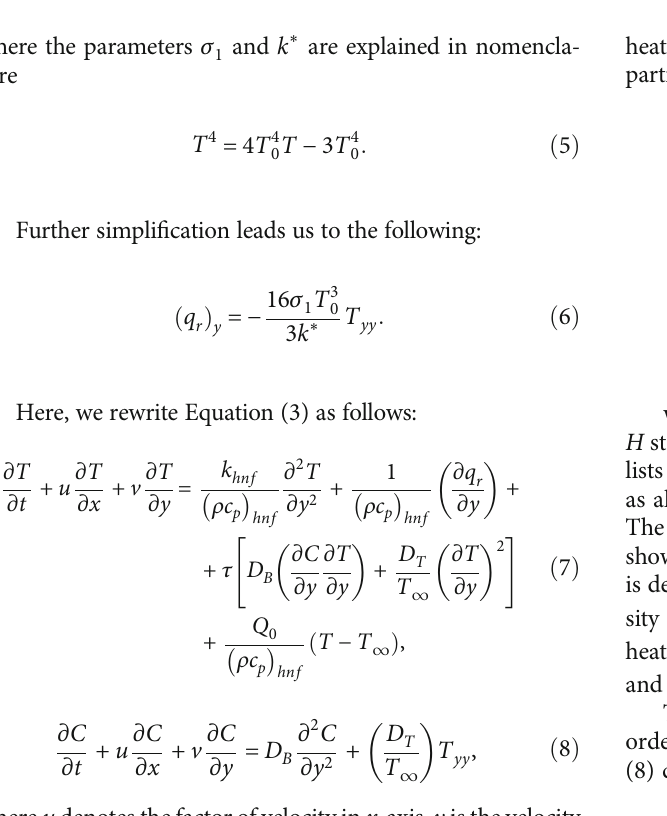
= 1 : 0, λ = 0 : 2, Q = 0 : 5, Pr = 6 : 5, M = 0 : 5, R = 0 : 1 r